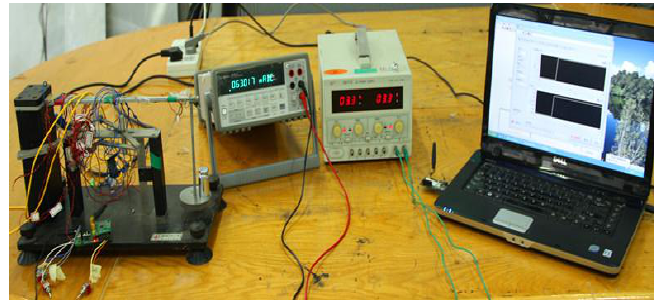
Figure 17. Experiment system to test power